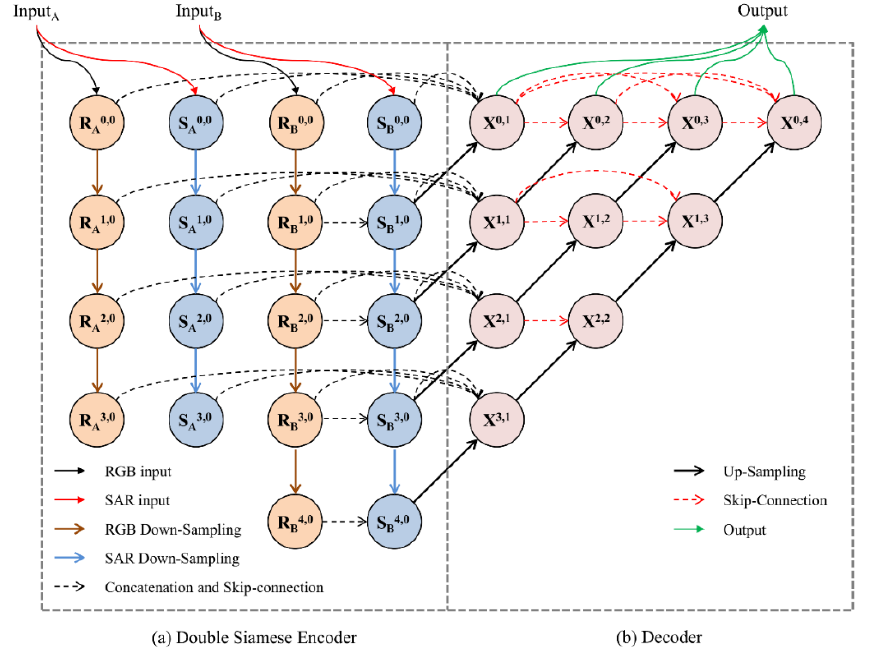
Figure 3. The encoder-decoder architecture of DSNUNet. ( a ) is the encoder structure of DSNUNet, consisting of two sets of Siamese branches; ( b ) is the decoder structure of Nested UNet.